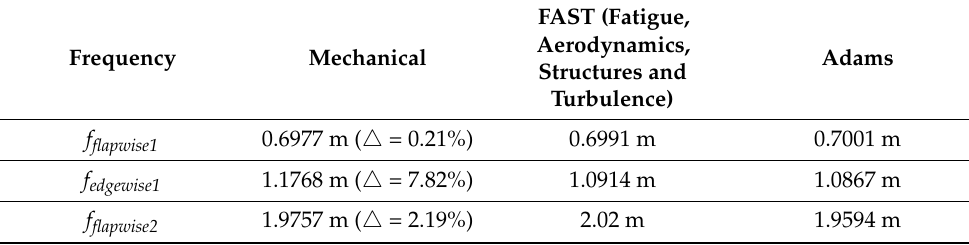
Figure 21. The solid mesh of blades. Table 3. Blade natural vibration frequency under different vibration